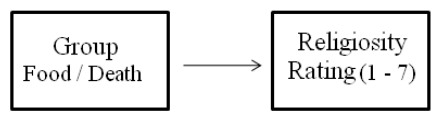
Figure 9. Simple variable-based model for study of Terror Management